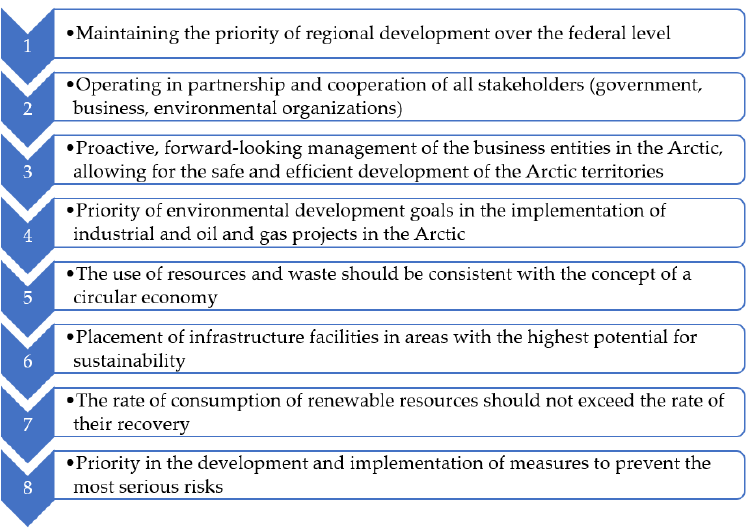
Figure 5. The principles of implementing oil and gas projects for the preservation of ecosystems.